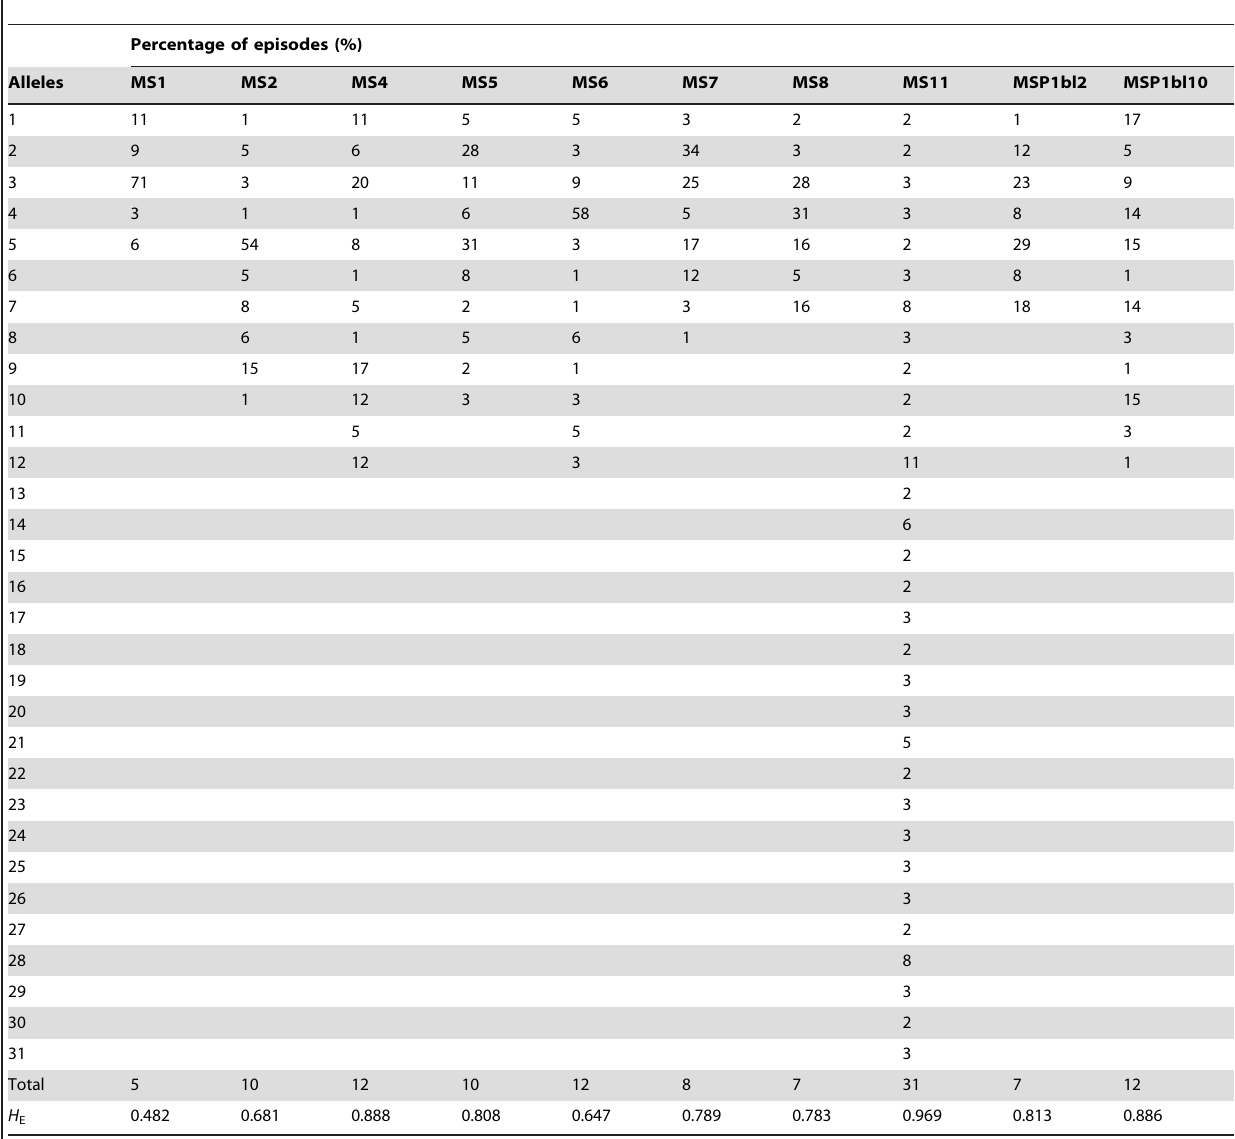
Table 1. Allele frequencies (%) and genetic variability of each molecular marker from Plasmodium vivax isolates.